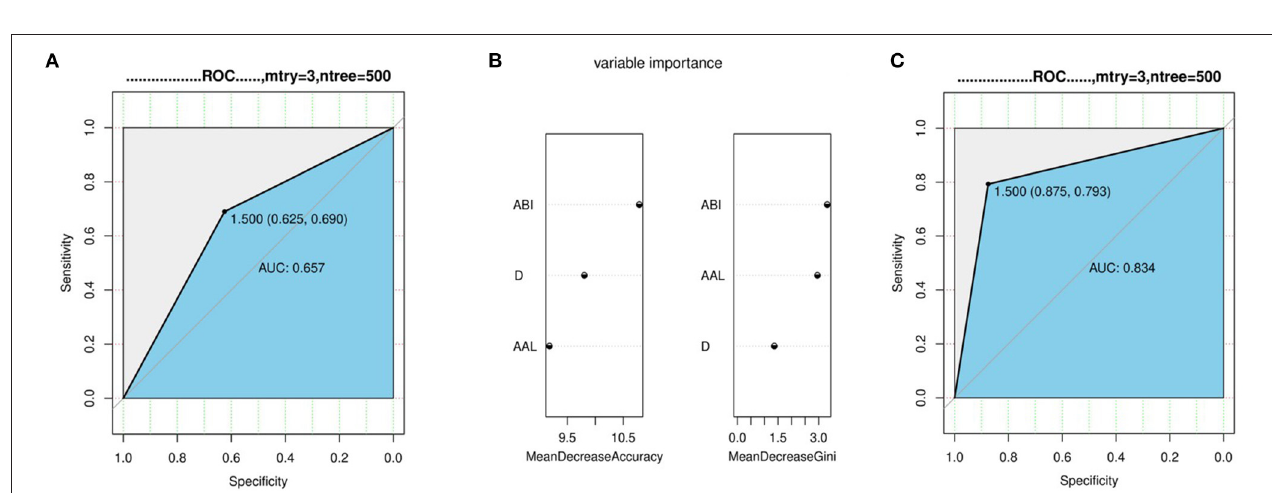
FIGURE 3 | Comparison of ascending aortic morphology. (A) Ascending aorta diameter. (B) AAL. (C) Relationship between aortic length and aortic rupture; rupture 1: the rupture in ascending aorta; rupture 2: the rupture in Distal ascending aorta. (D) ABI. (E) Ascending aortic angle. (F) HWR.